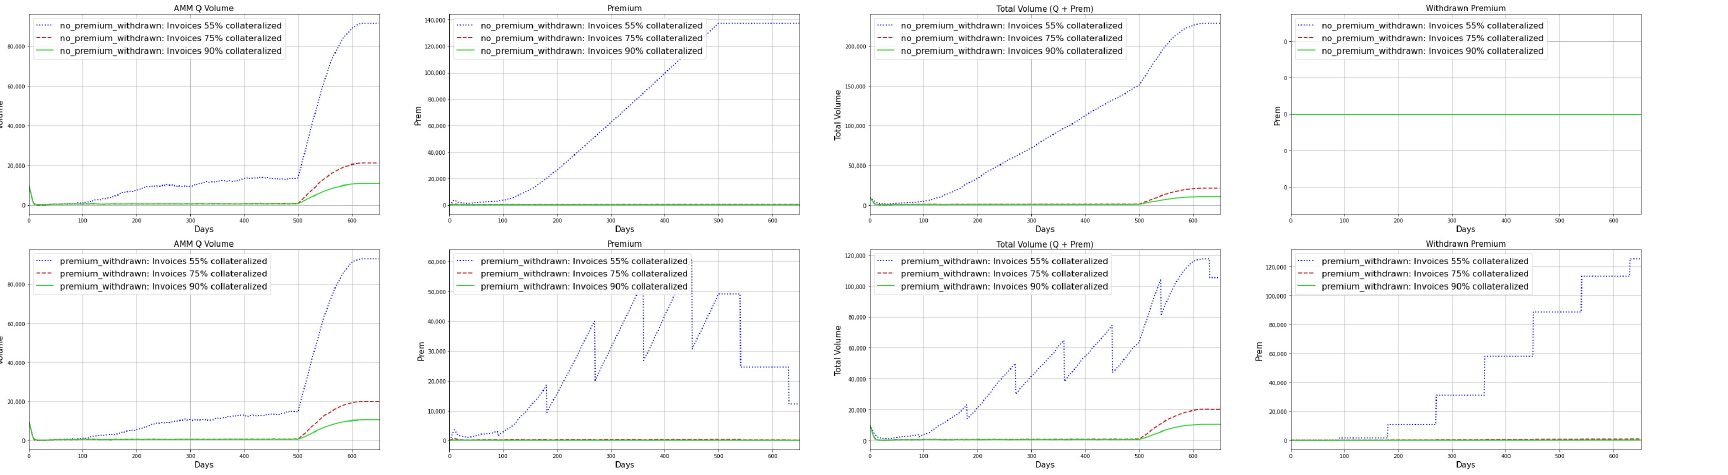
Figure A14. rkAMM Curves from simulation of scenario 5 and 90 days of withdrawal